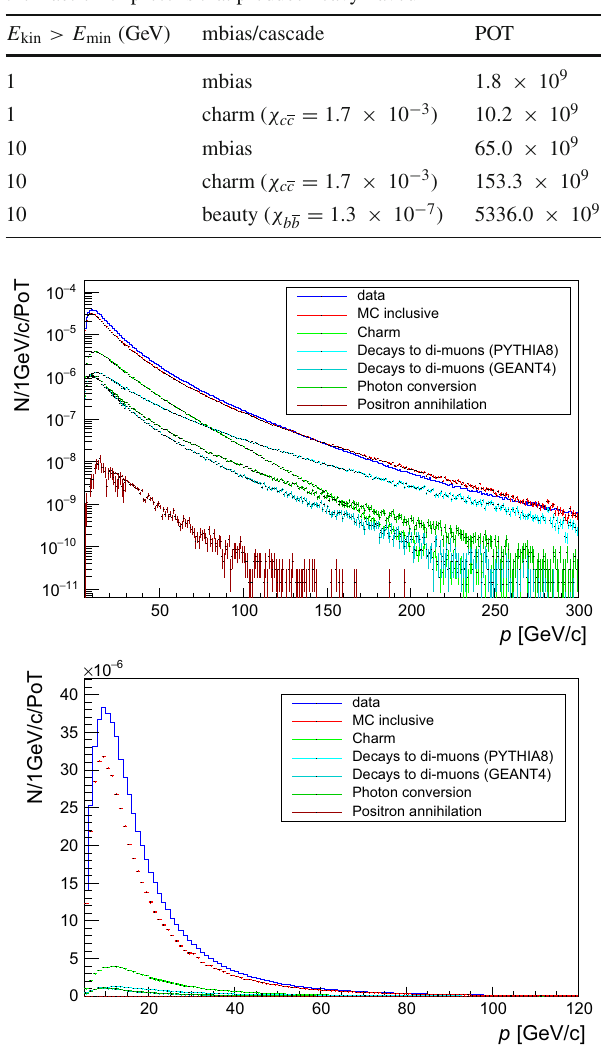
Fig. 5 Measured muon momentum distributions from data and sim- ulation, top full range in log scale, bottom detail of the low momen- tum range with a linear scale. The distributions are normalized to the number of POT. For simulated data, some individual sources are high- lighted, muons from charm (green), from dimuon decays of low-mass resonances in Pythia8 (cyan), in Geant4 (turquoise), photon conversion (dark green) and positron annihilation (brown)